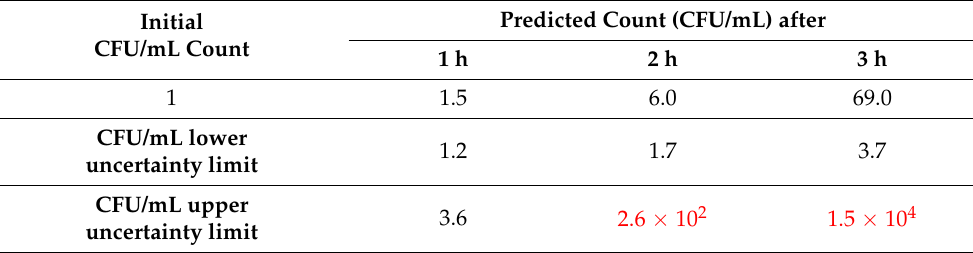
Table 5. The prediction of B. cereus CFU/mL concentration for an initial post-pasteurization concen- tration equal to the limit of detection and after 1, 2, and 3 h of storage at +42 ◦ C (calculated mean values and the lower and upper limits of uncertainty).